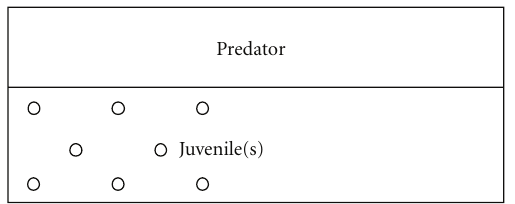
Figure 1: Experimental aquarium divided into a predator and a juvenile section using a Plexiglas divider. The vegetated habitat is to the left in the juvenile section.